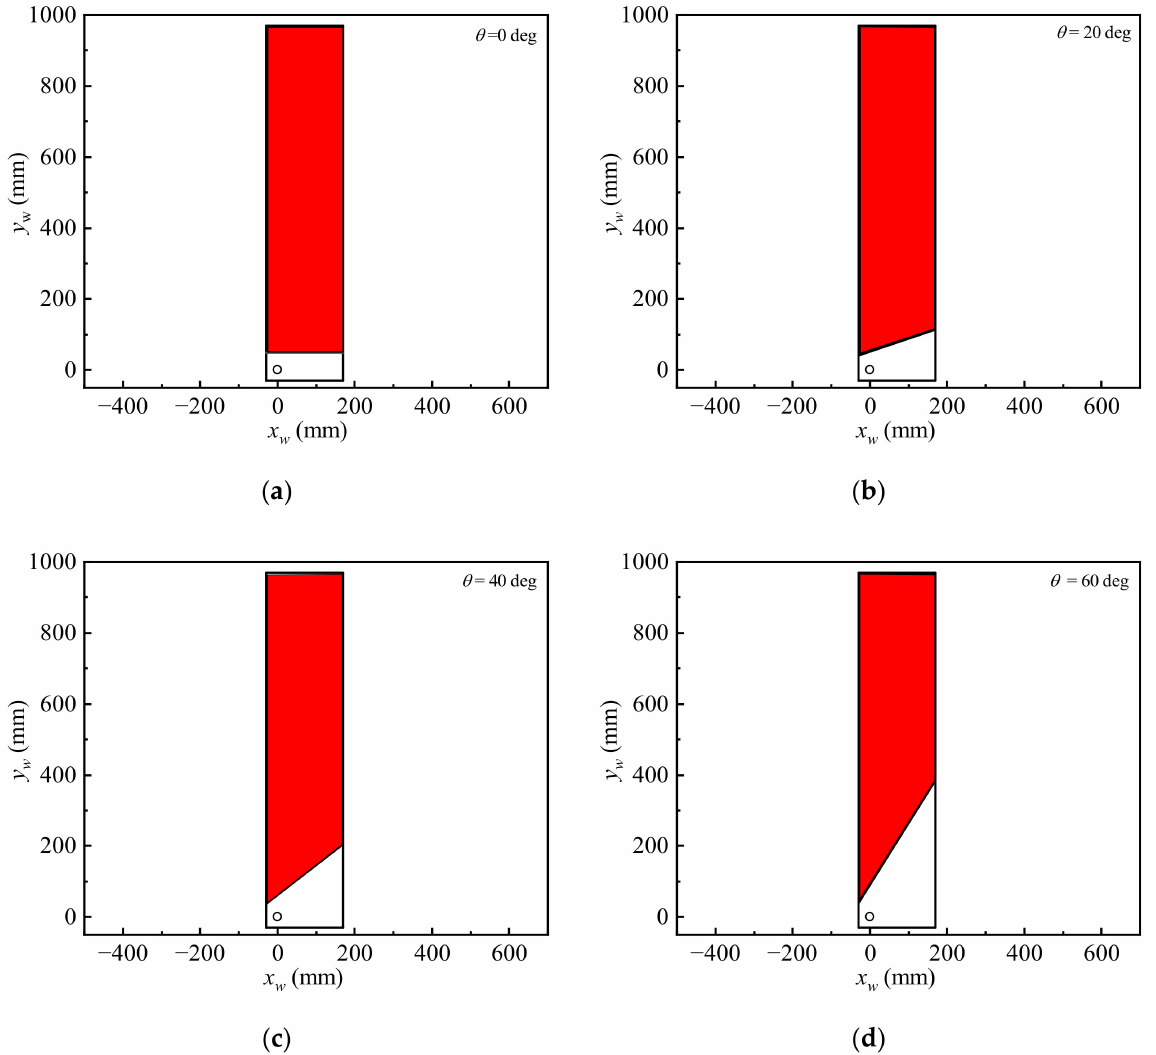
Figure 8. The time-varying effective lifting surface. ( a ) Sweep angle is 0 deg. ( b ) Sweep angle is 20 deg. ( c ) Sweep angle is 40 deg. ( d ) Sweep angle is 60